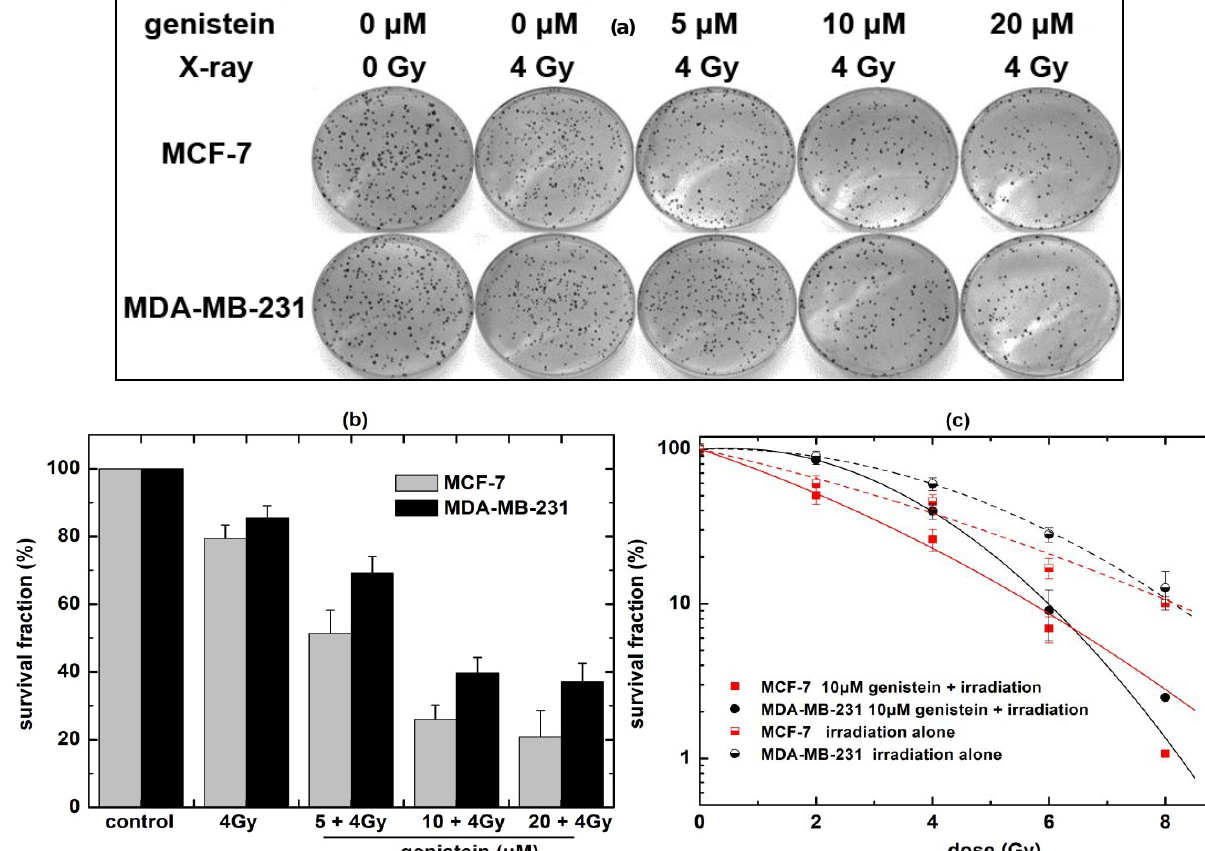
Figure 3. Effect of genistein on the clonogenic survival of MCF-7 and MDA-MB-231 cells. Logarithm growing period cells were pretreated with genistein for 24 h followed by X-ray irradiation. After incubation for 15 days, colonies with cells greater than 50 were counted. All data are presented as means ± SD from three independent